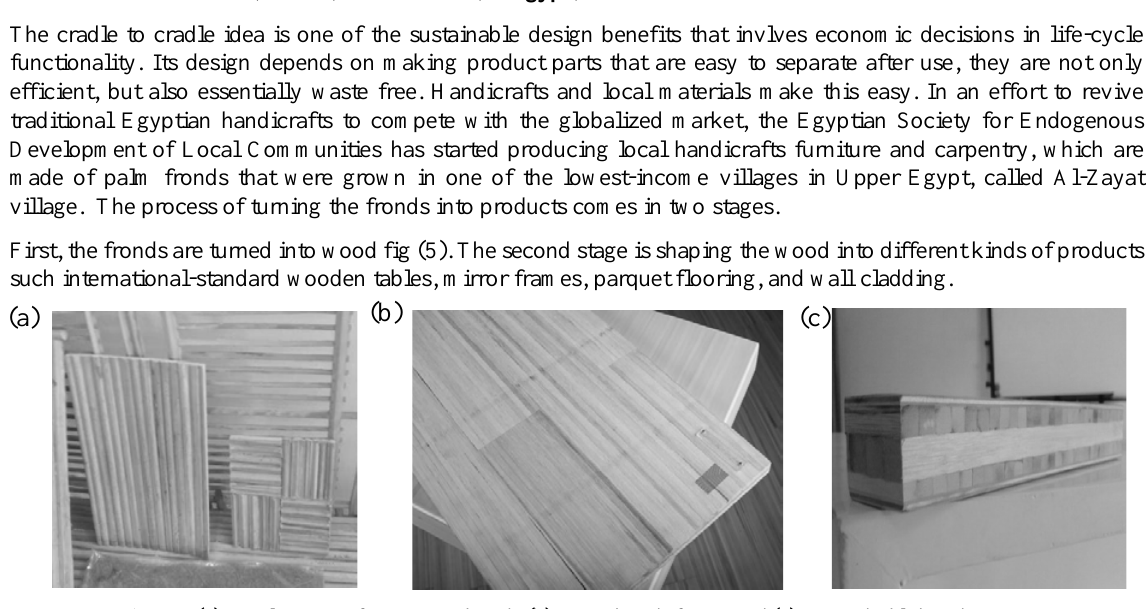
Figure 5. (a) Samples cut out from DPLM board , (b) DPLM board after treated (c) DPLM double board as a sandwich panel. (a)(c)Source:[Egyptian Association for self-development of local communities, Egypt, researcher photo]